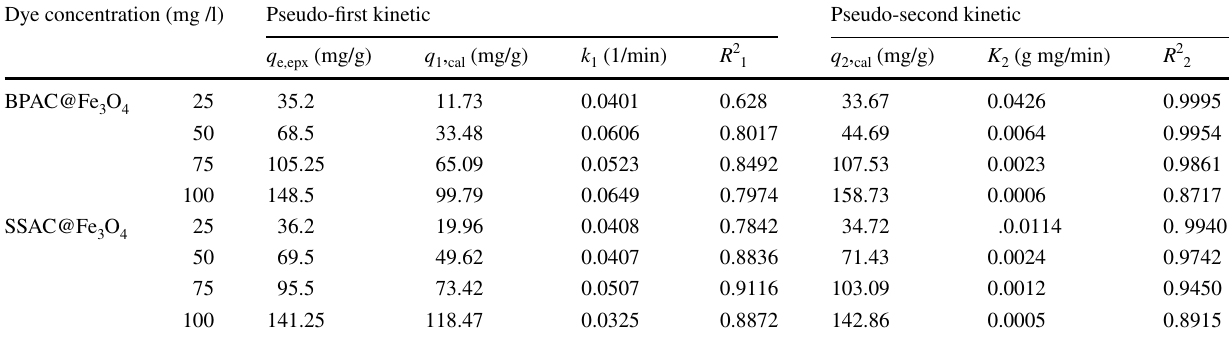
Table 4 The kinetics of adsorption reactions for the removal of BB41 dye by adsorption process Dye concentration (mg